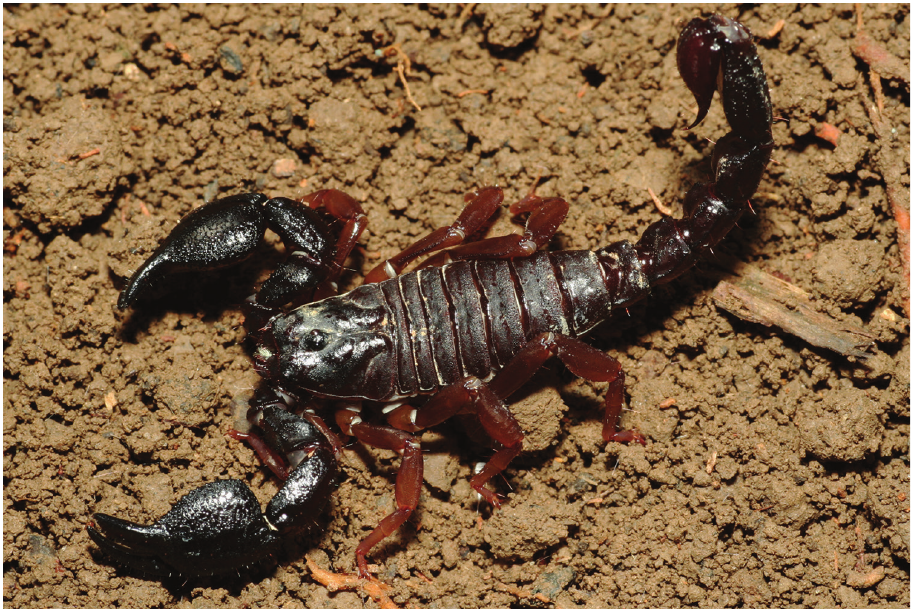
Figure 22. Broteochactas delicatus , male from